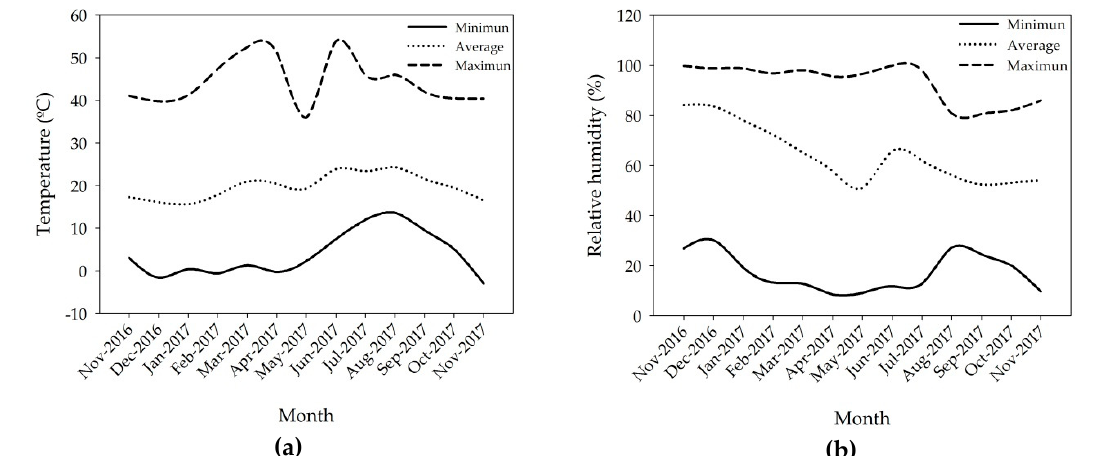
Figure 1. Environmental conditions recorded during the production of Pinus cembroides Zucc. from November 2016 to November 2017: Temperature ( a ) and relative humidity ( b